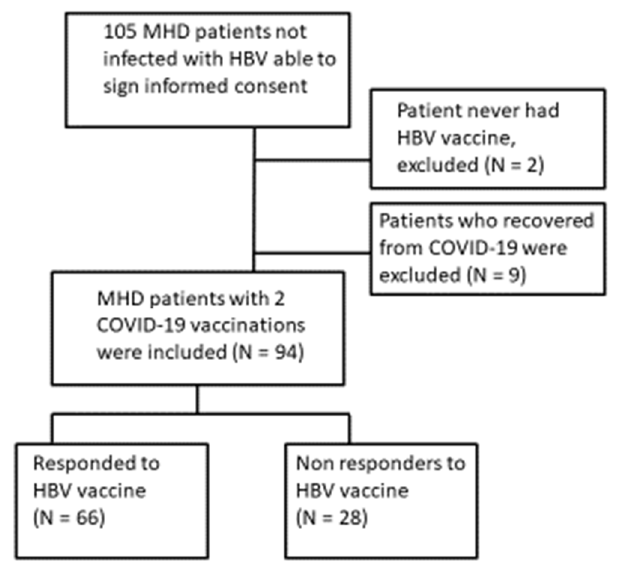
Figure 1. Study cohort. Table 1. Clinical, demographic and baseline laboratory data of study cohort by response to HBV